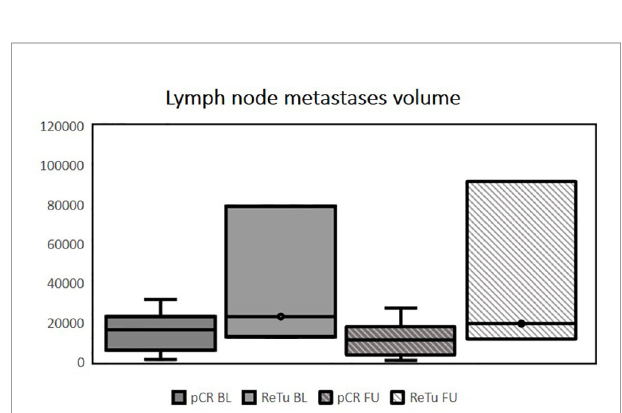
FIGURE 3 | Whole tumor volume of both primary tumor and lymph node metastases in mm 3 , outliers are marked with dots, no signi fi cant differences among groups at baseline or follow-up were present using the Kruskal-Wallis test (pCR BL, pathologic complete response at baseline; ReTu BL, residual tumor at baseline, pCR FU, pathologic complete response at follow up; ReTu FU, residual tumor at follow up).